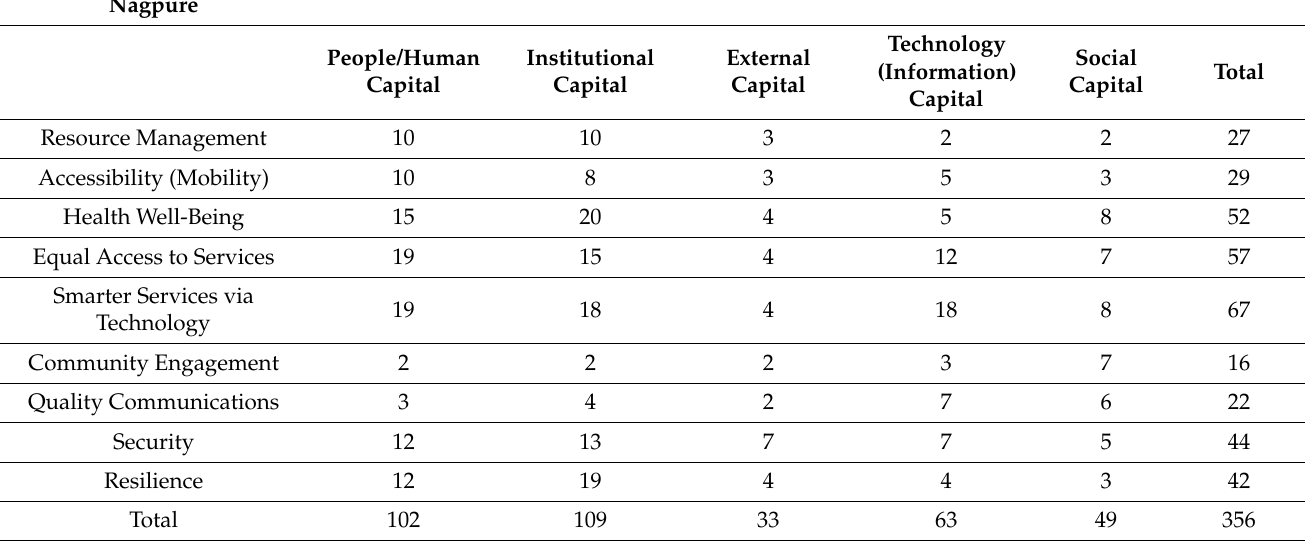
Table 3. Nagpur—number of actions/initiatives (soft asset consideration).